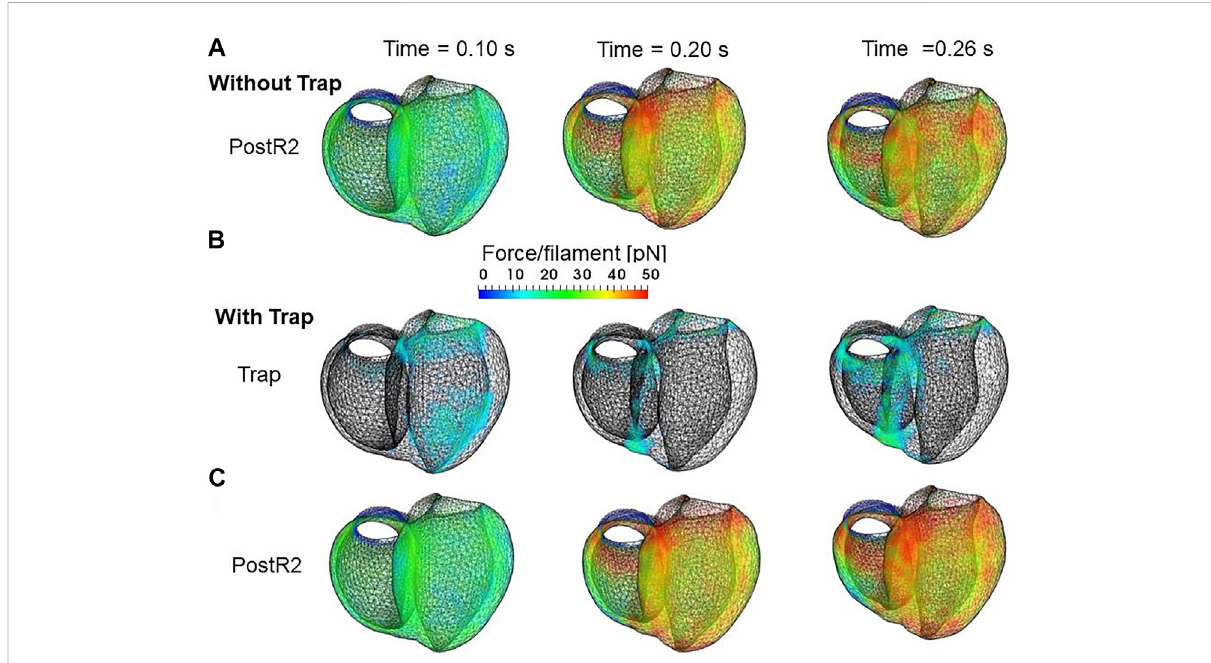
FIGURE 13 Distributionofcontractionforcesintheventriclesinthesystolicphaseattheearlysystole:0.10 s(left),atthemid-systole:0.20 s(center),andat theend-systole:0.26 s(right)for (A) theXB PostR2 stateintheno-trapmodel (B) XB Trap ,and (C) theXB PostR2 stateinthetrapmodel.In (B) ,theregionsin which the forces are less than 10 pN are